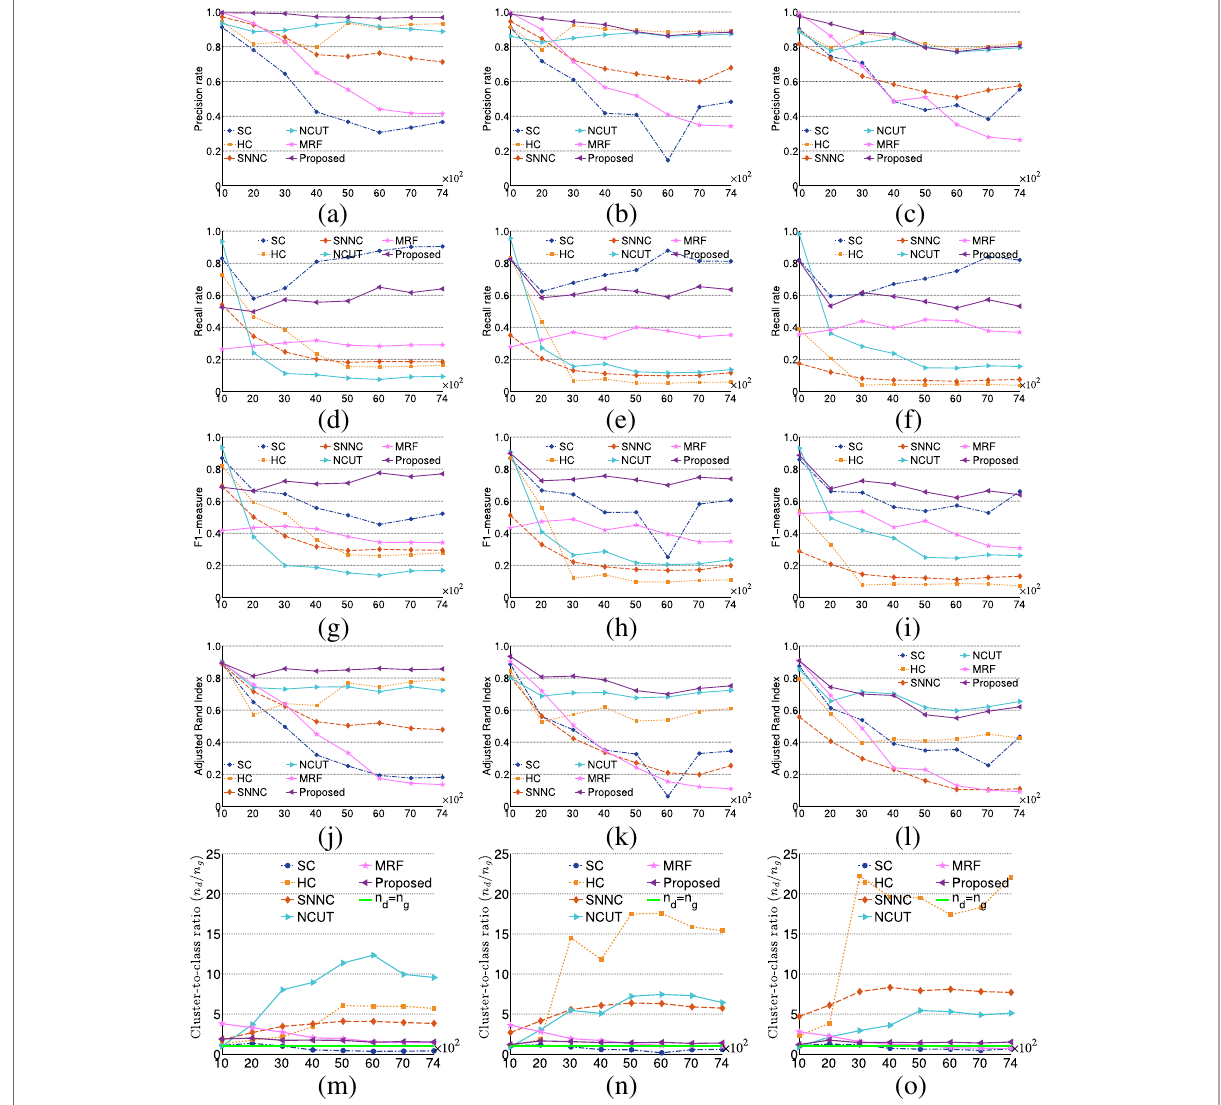
Fig. 4 Comparison of different clustering algorithms on datasets of varying sizes. a Precision rates, image block size s = 1024 × 1024 pixels; b precision rates, s = 512 × 512; c precision rates, s = 512 × 256; d recall rates, s = 1024 × 1024; e recall rates, s = 512 × 512; f recall rates, s = 512 × 256; g F1-measures, s = 1024 × 1024; h F1-measures, s = 512 × 512; i F1-measures, s = 512 × 256; j adjusted Rand Indexes, s = 1024 × 1024; k adjusted Rand Indexes, s = 512 × 512; l adjusted Rand Indexes, s = 512 × 256; m cluster-to-class ratios, s = 1024 × 1024; n cluster-to-class ratios, s = 512 × 512; and o cluster-to-class ratios, s = 512 ×